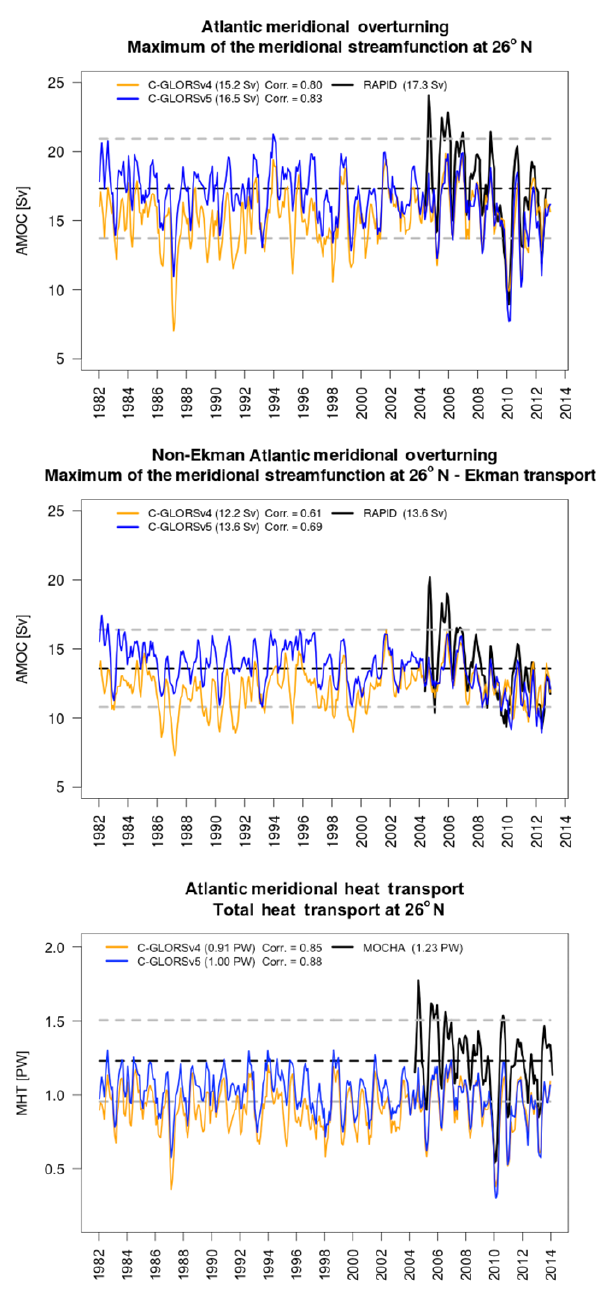
Figure 11. Atlantic meridional overturning (AMOC, top panel, de- fined as maximum of the meridional streamfunction at 26.5 ◦ N), non-Ekman component of the meridional streamfunction (AMOC minus Ekman transport, middle panel) and heat transport (MHT, bottom panel) for C-GLORSv4, C-GLORSv5 and the RAPID- MOCHA array. Units are Sv (1Sv = 1 × 10 + 6 m 3 s − 1 ) and PW (1PW = 1 × 10 + 15 Watts) for the overturning streamfunction and the heat transport, respectively. The plots also show (in dashed lines) the RAPID-MOCHA mean values (black lines) ± 1 standard deviation (grey